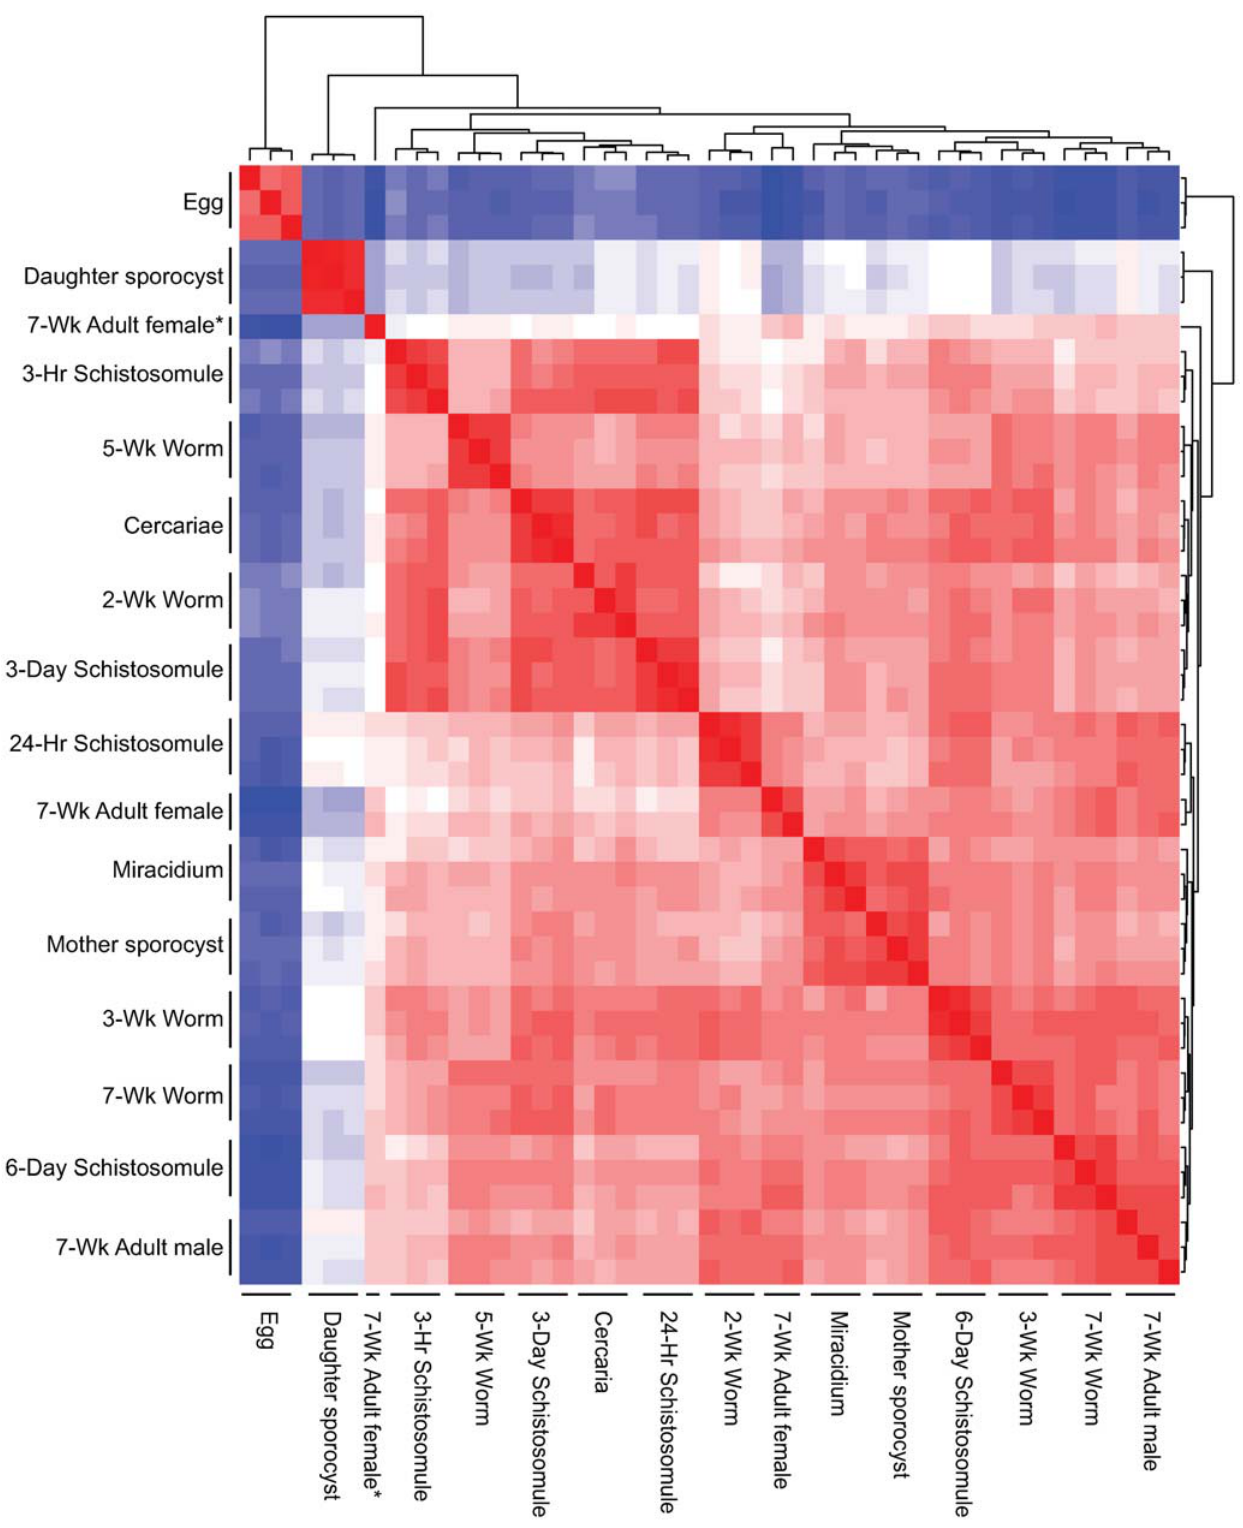
Figure 1. Egg and daughter sporocyst parasite stages display the most divergent transcriptional profiles within the Schistosoma lifecycle. Correlations of M (log 2 (Alexafluor647/Alexafluor555)) ratio values between intra- (lifecycle replicate) and inter- (life-stage comparison) parasite samples were calculated. A heatmap of the correlations, calculated on data normalised within each DNA microarray, is illustrated. Red represents a high correlation and blue depicts a low or lower correlation. Un-scaled data were clustered by Euclidean distance and shown as dendrograms above and to the left of the heatmap. * Indicates female sample replicate manually removed.